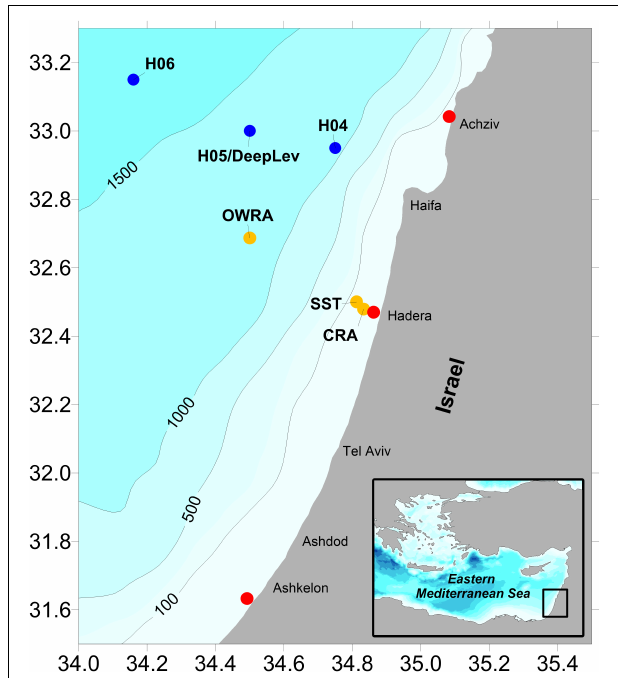
FIGURE 1 | Spatial coverage of used datasets. Coastal stations locations (red). CMEMS reanalysis and SST positions (yellow). DeepLev and Haifa Section open water stations